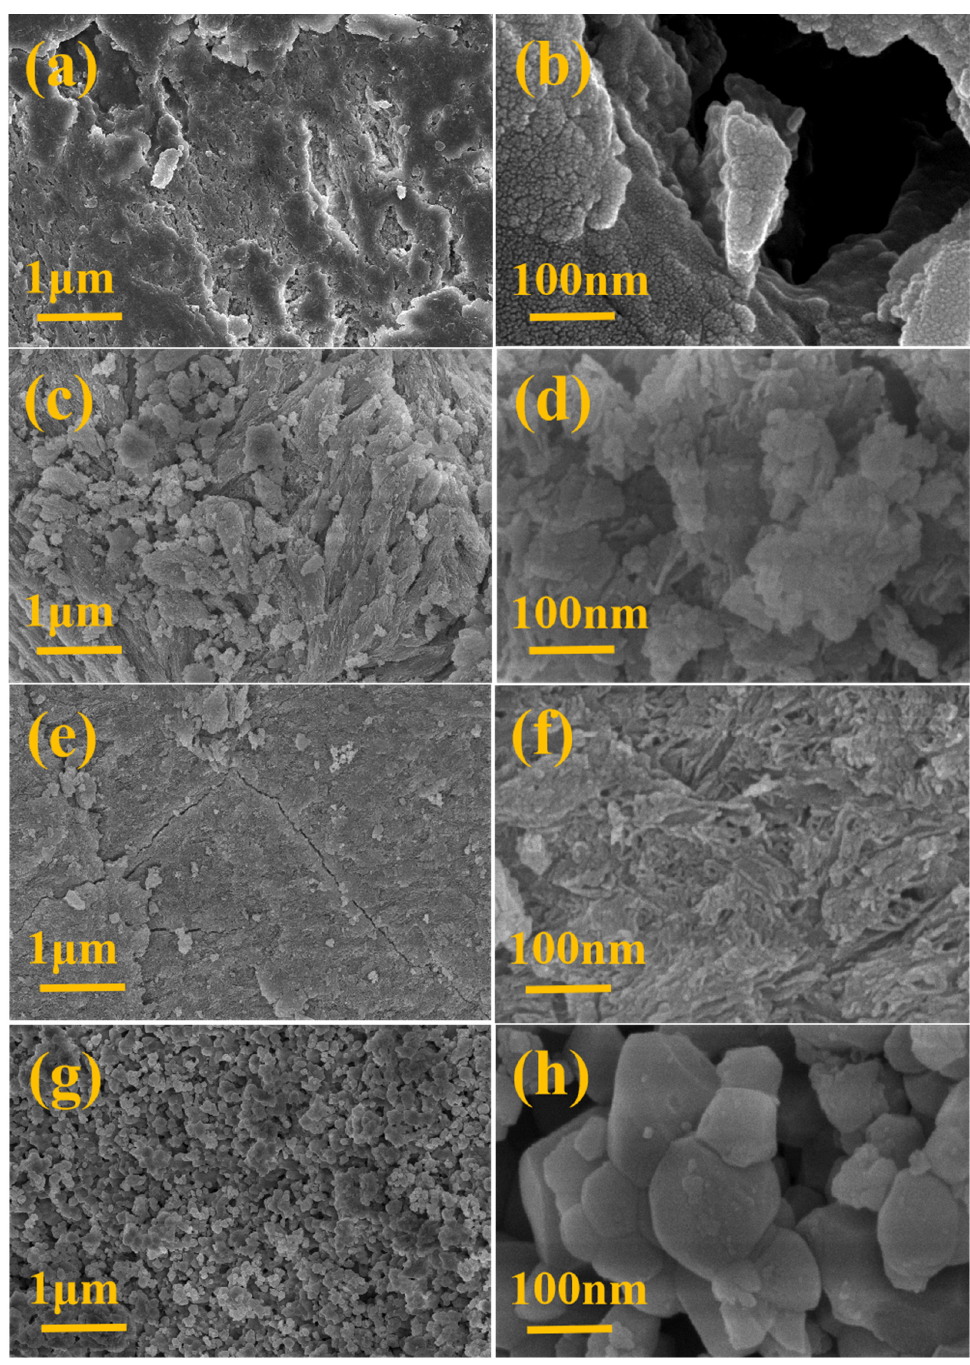
Figure 1. The SEM images of BC and BCH samples: RB ( a , b ), BCH-300 ( c , d ), BC-300 ( e , f ), BC-900 ( g , h ).